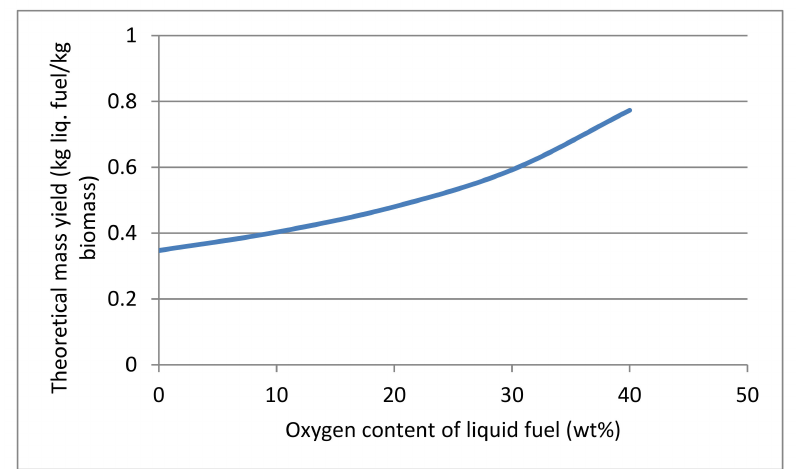
Figure 3. Variation in theoretical mass yield of liquid fuel from biomass with variation in the final oxygen content of the fuel after biomass conversion (for theoretical mass yield, zero losses to char, coke and gases are assumed and all oxygen is assumed to be removed as CO 2